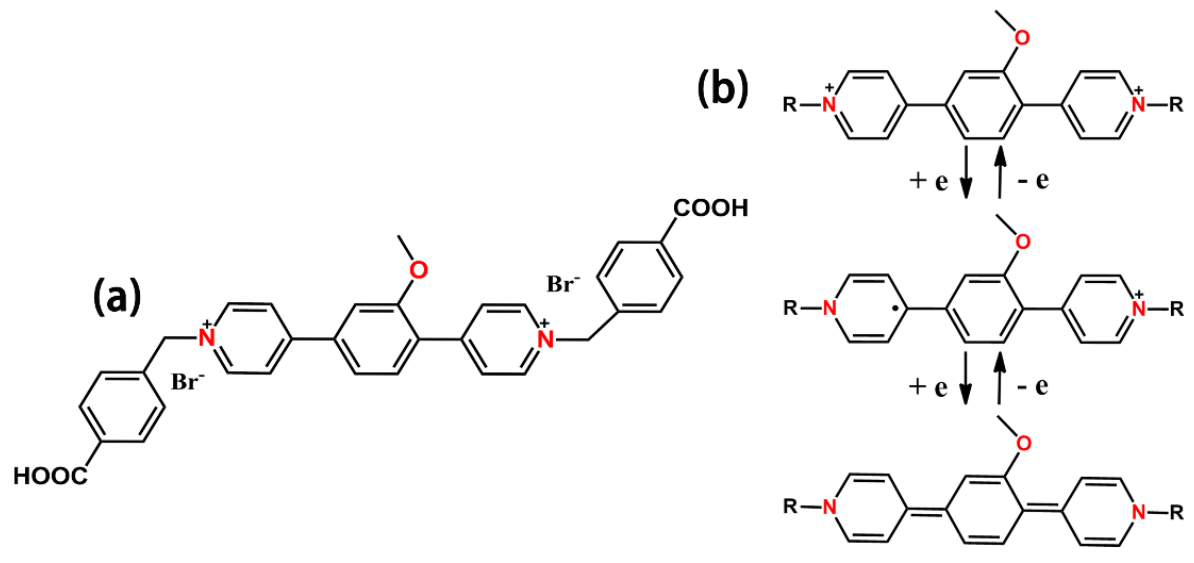
Figure 1. ( a ) The chemical structure of Oxv. ( b ) Stepwise reduction of the Oxv unit.